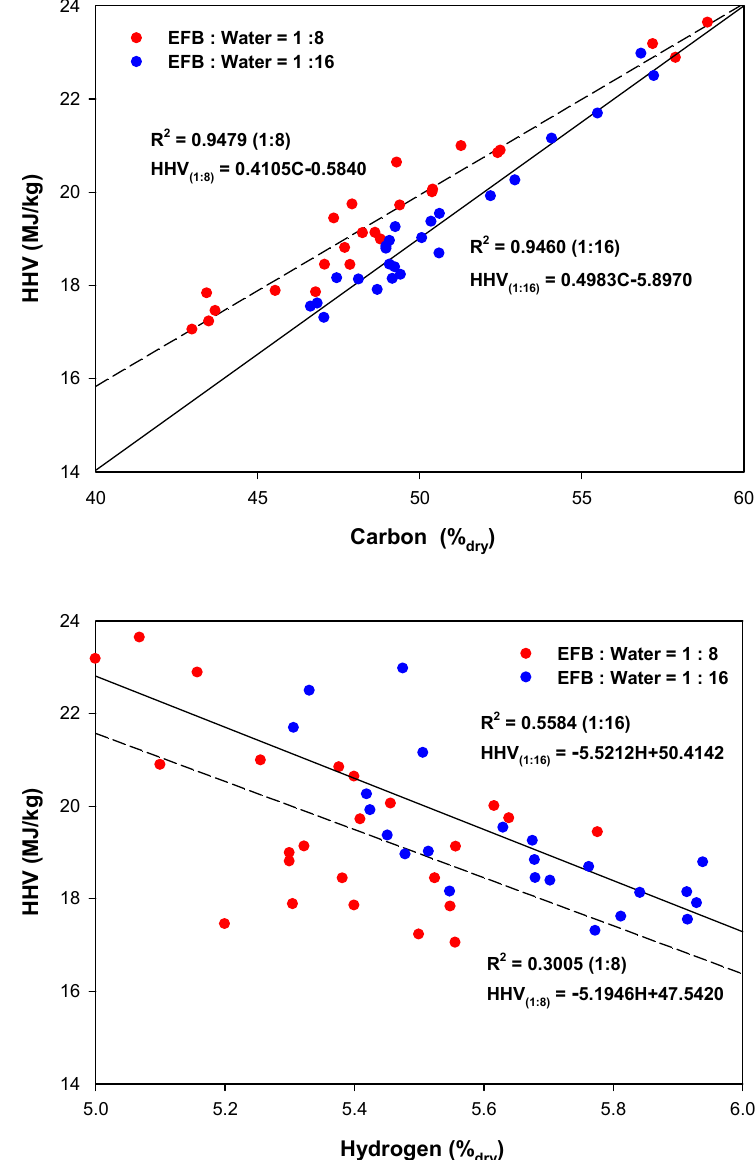
Figure 6. Correlations between carbon and hydrogen contents and the heating value of hydrothermally treated EFB: ( top ) carbon–HHV; ( bottom ) hydrogen–HHV.